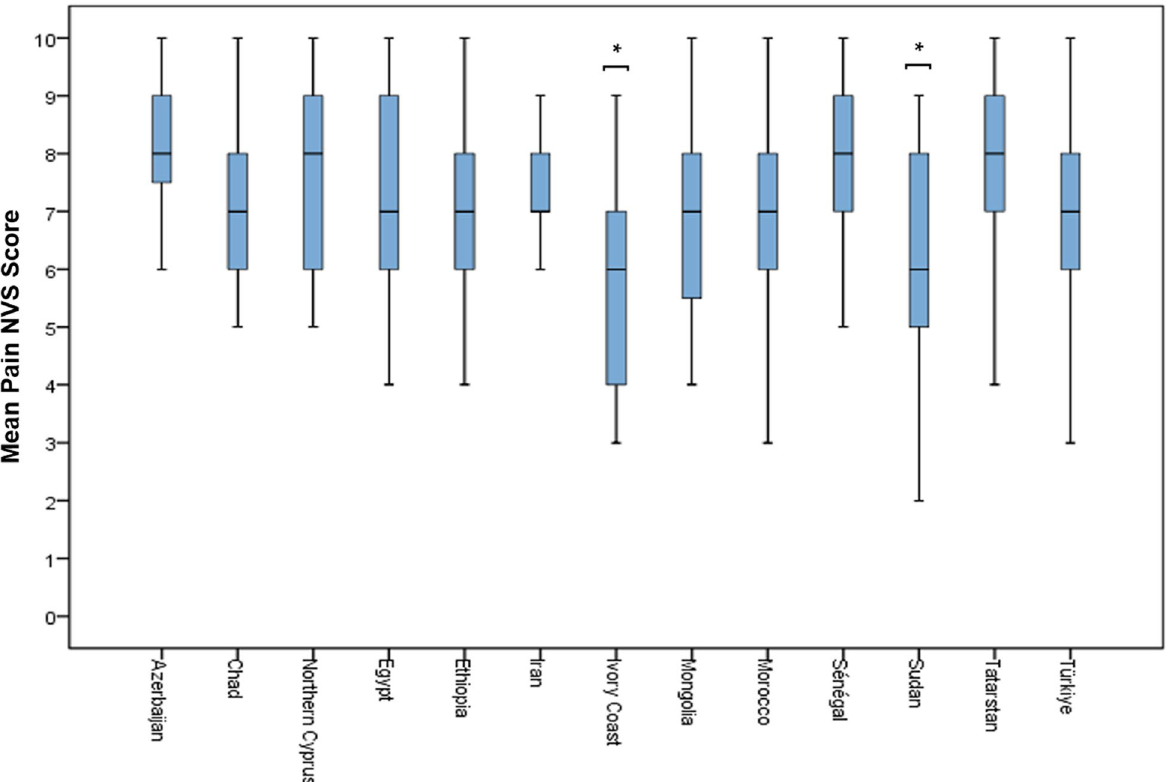
Fig. 2 Distribution of mean severity of headache according to countries (*different than Türkiye, Turkish Republic of Northern Cyprus, Iran, Egypt, Senegal, Tatarstan, and Azerbaijan, p <